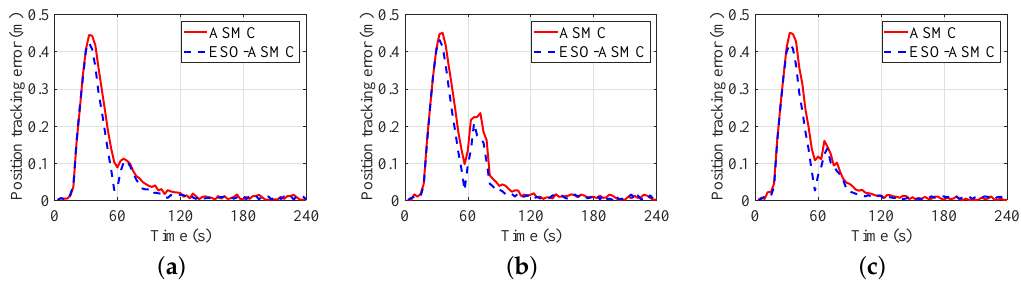
Figure 7. Position tracking errors. ( a ) Group A. ( b ) Group B. ( c ) Group